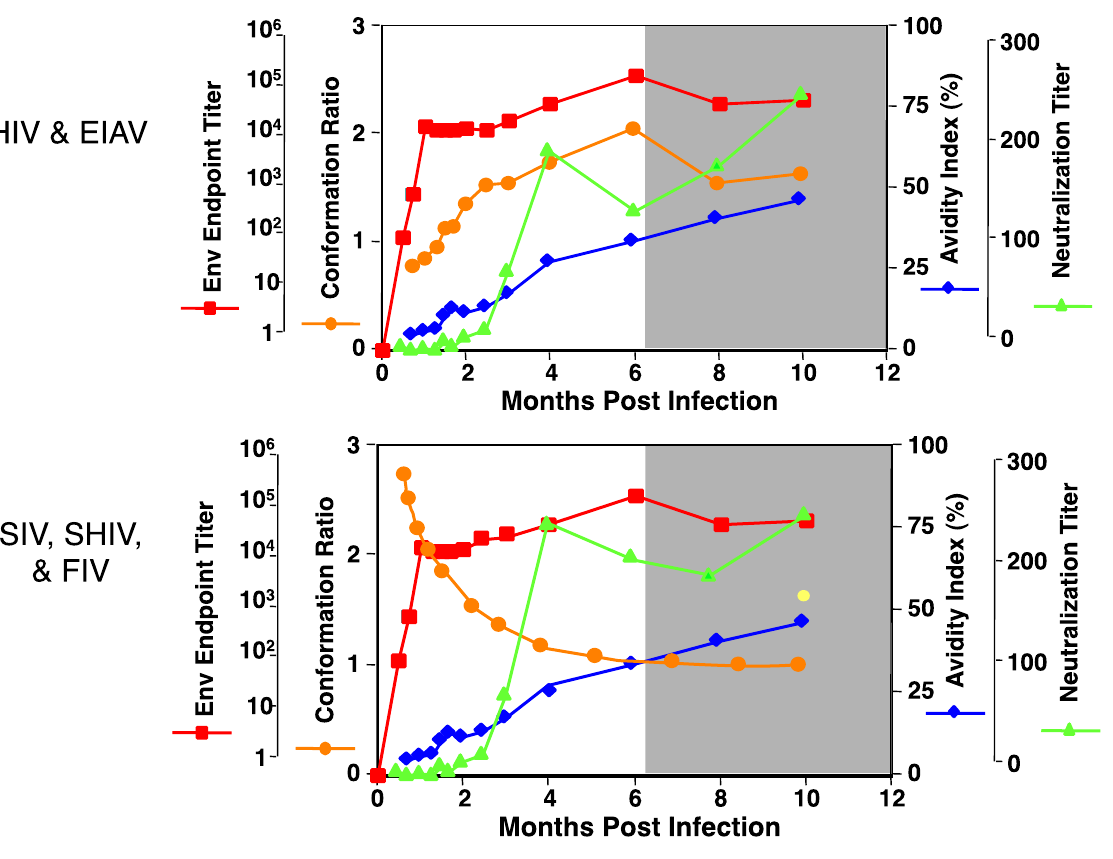
Figure 5. Schematic representation of lentiviral immune maturation. Development of mature immunity (grey-shaded box) occurs by 6–8 months post-infection. Red, reciprocal endpoint titer; Orange, conformational ratio; Blue, avidity index; Green, reciprocal neutralization titer (Figure modified from original in Montelaro et al .